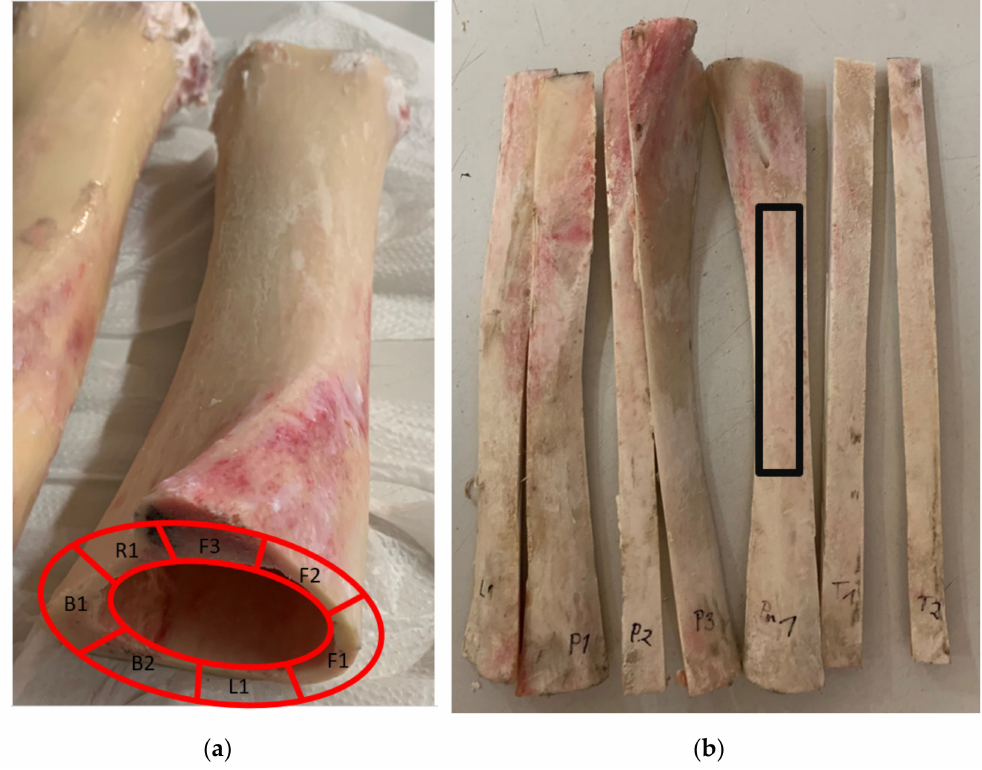
Figure 3. ( a ) Shows the bone after pretreatment with the relevant description, and ( b ) shows the cut pieces of bone that were prepared for cutting out the samples. F1, F2, F3—first, second and third sample from front part of the bone, L1—sample from left side, R1—sample from right side, B1, B2—first and second sample from back part, black box—approximate cutout location of the final